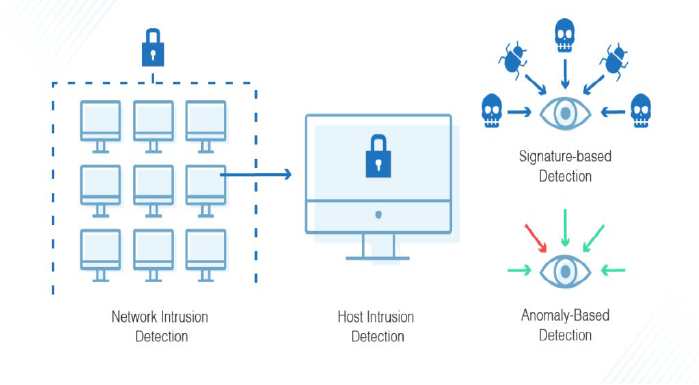
Figure 1. Intrusion Detection System model.